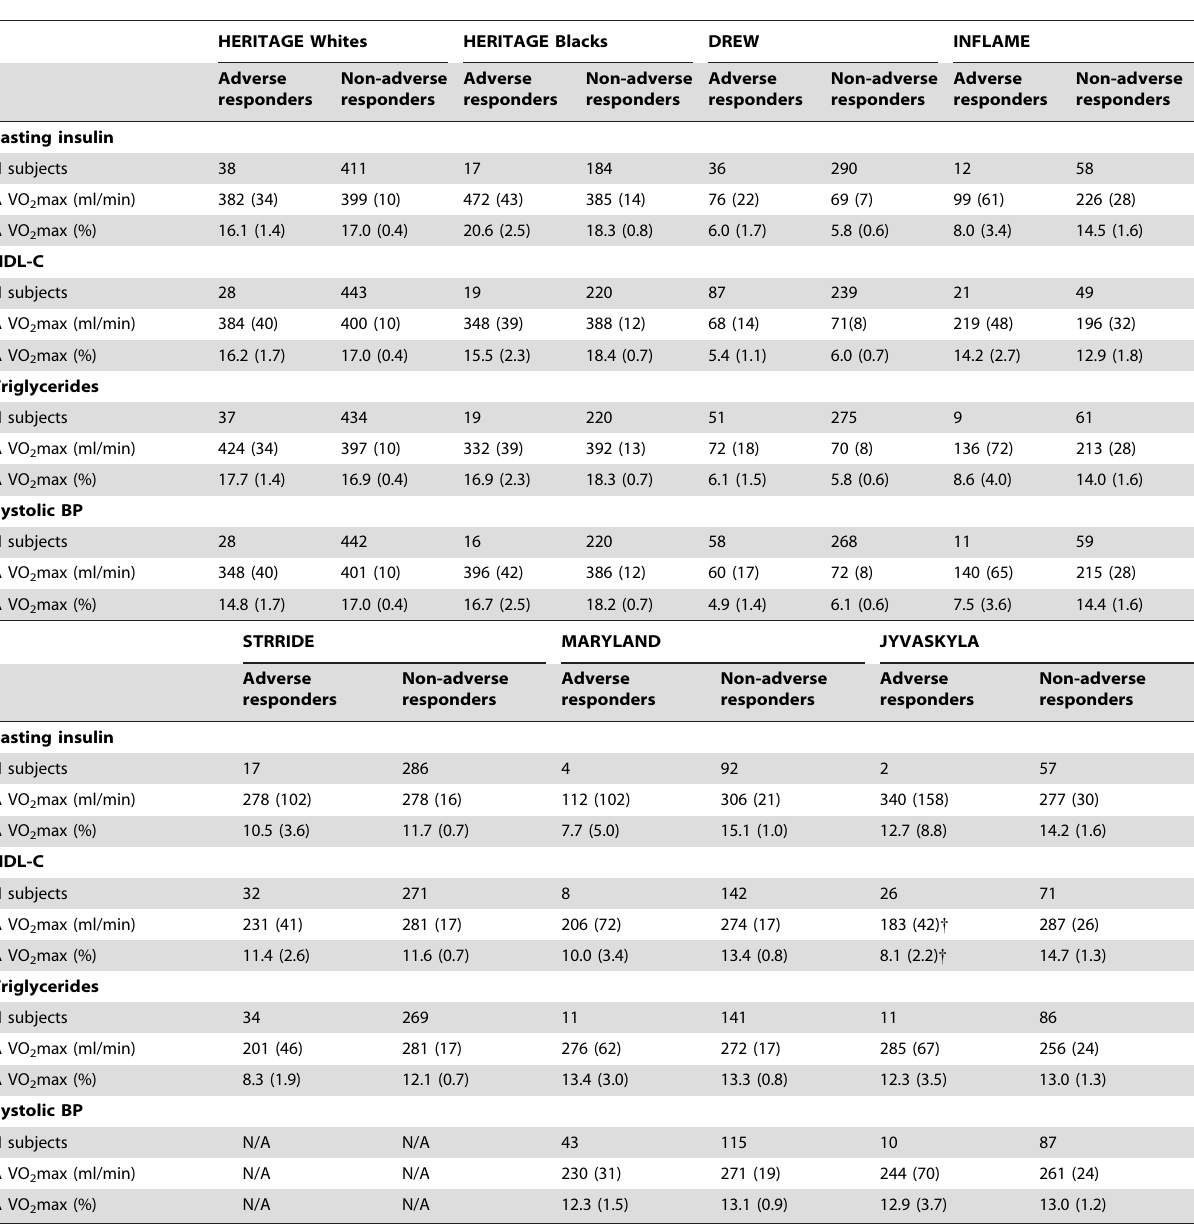
Table 6. Comparison of the VO2max response to regular exercise between adverse responders and non-adverse responders for each response trait in each